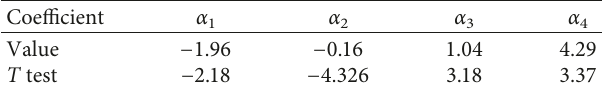
Figure 3: PD cell distributions corresponding to different values of f (d) u � 0.167 l , f 2 � 0.6; (e) u � 0.226 l , f 2 � 0.8; (f) u � 0.382 l , f 2 � 1.0. Table 1: Fitting results of the binary logit model.